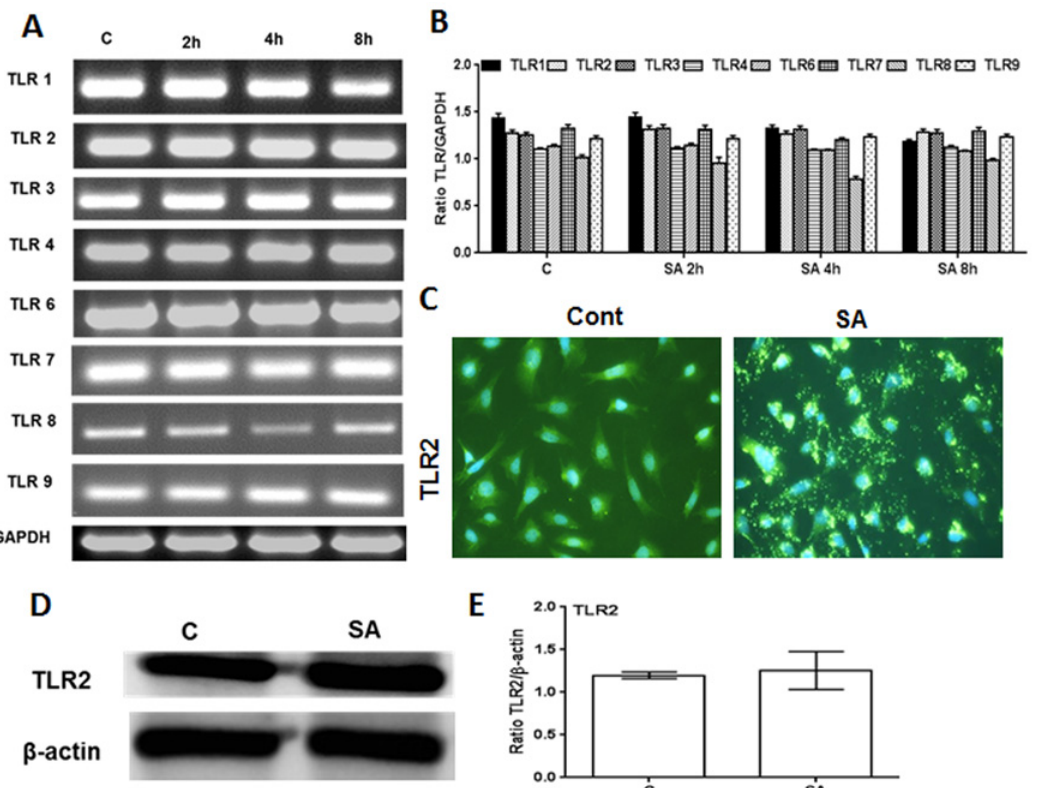
Fig 5. Modulation of TLR expression in 661 W cells following S. aureus challenge. 661W cells were stimulated with S . aureus (MOI 20:1) for the indicated time points. Total RNA was extracted, reverse transcribed, and subjected to semi-quantitative PCR for various TLRs (A). Band intensity was quantified by densitometric analysis using image J analysis software (NIH) and presented as the relative band intensity of TLRs vs. GAPDH (B). In a separate experiment, 661W cells were challenged with S . aureus (MOI 20:1) for 8 h and Immunostaining was performed using TLR2 specific antibody (C). TLR2 expression was further confirmed by Western blot analysis (D) and band intensity was quantified using Image J (E).